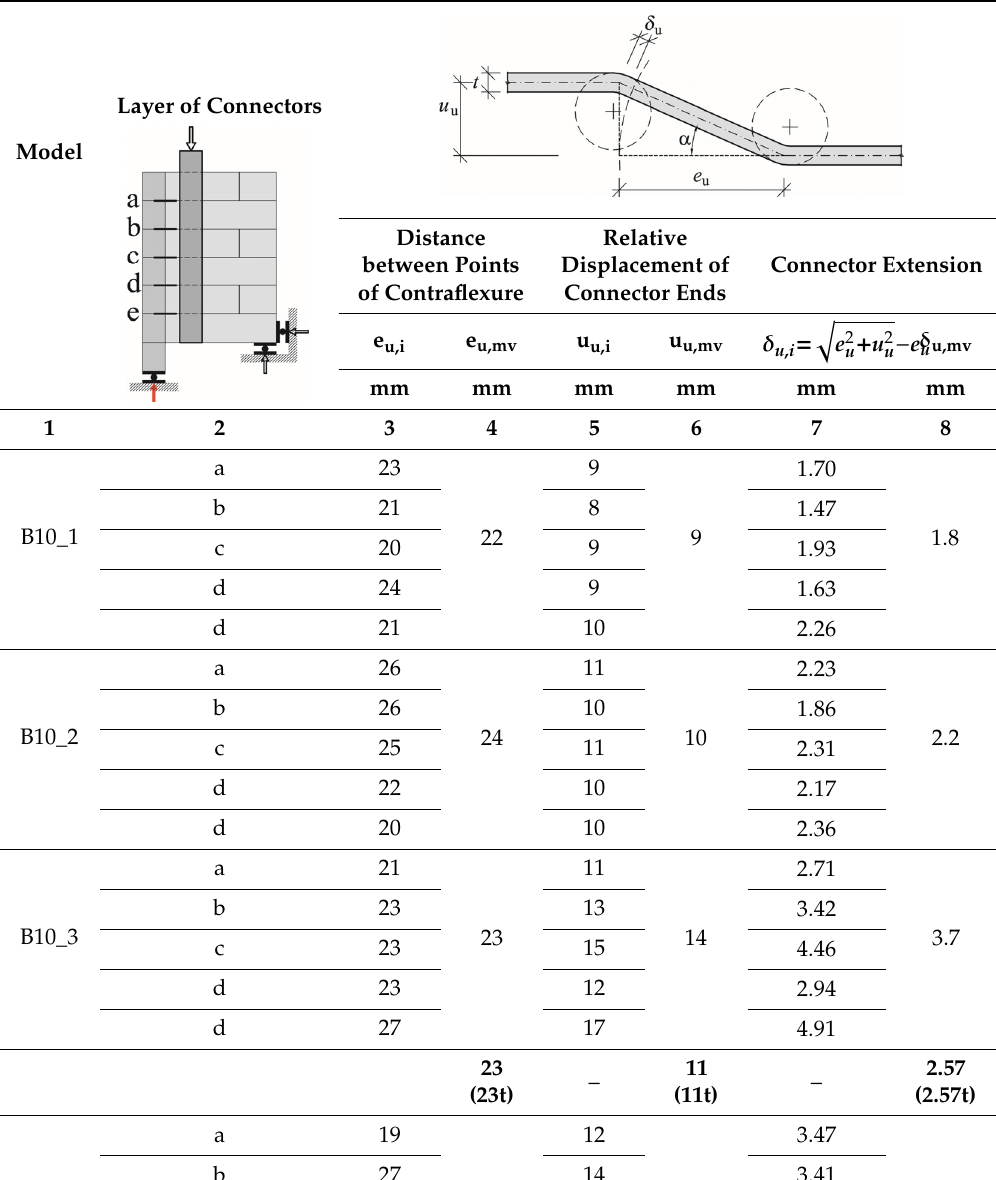
Table 8. Measured geometry of deformed connectors.